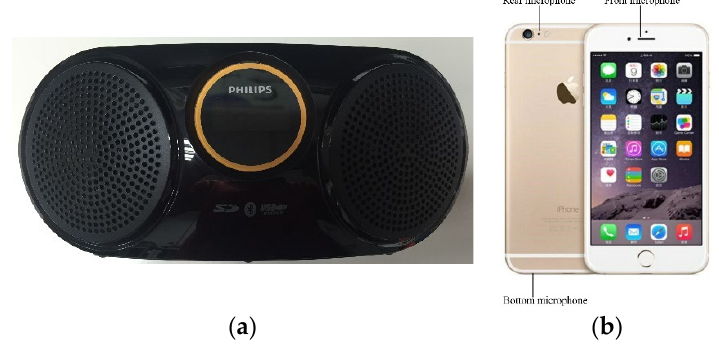
Figure 5. The used devices : ( a ) Wireless speaker (Philips AT10). ( b ) iPhone6. Table 1. Specifications of the Philips AT10.